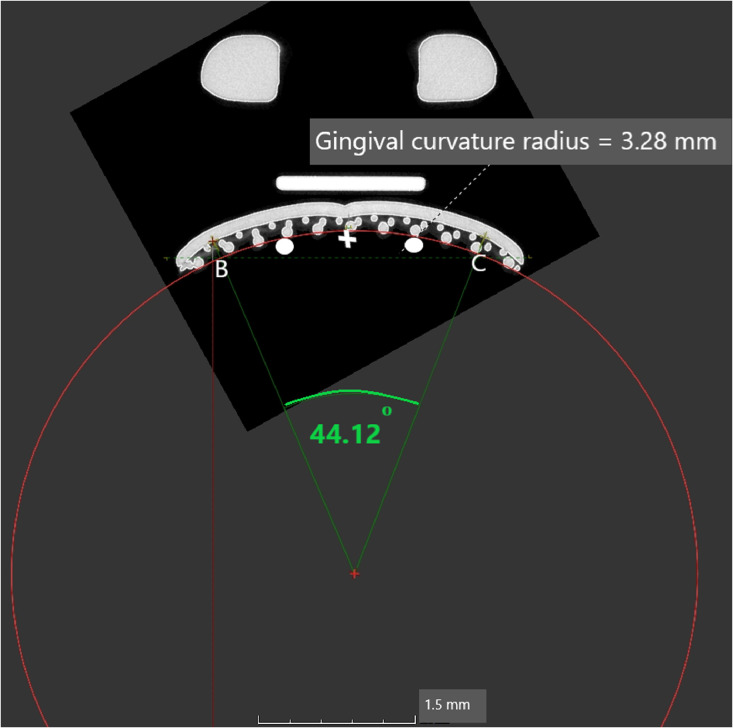
The gingival curve.